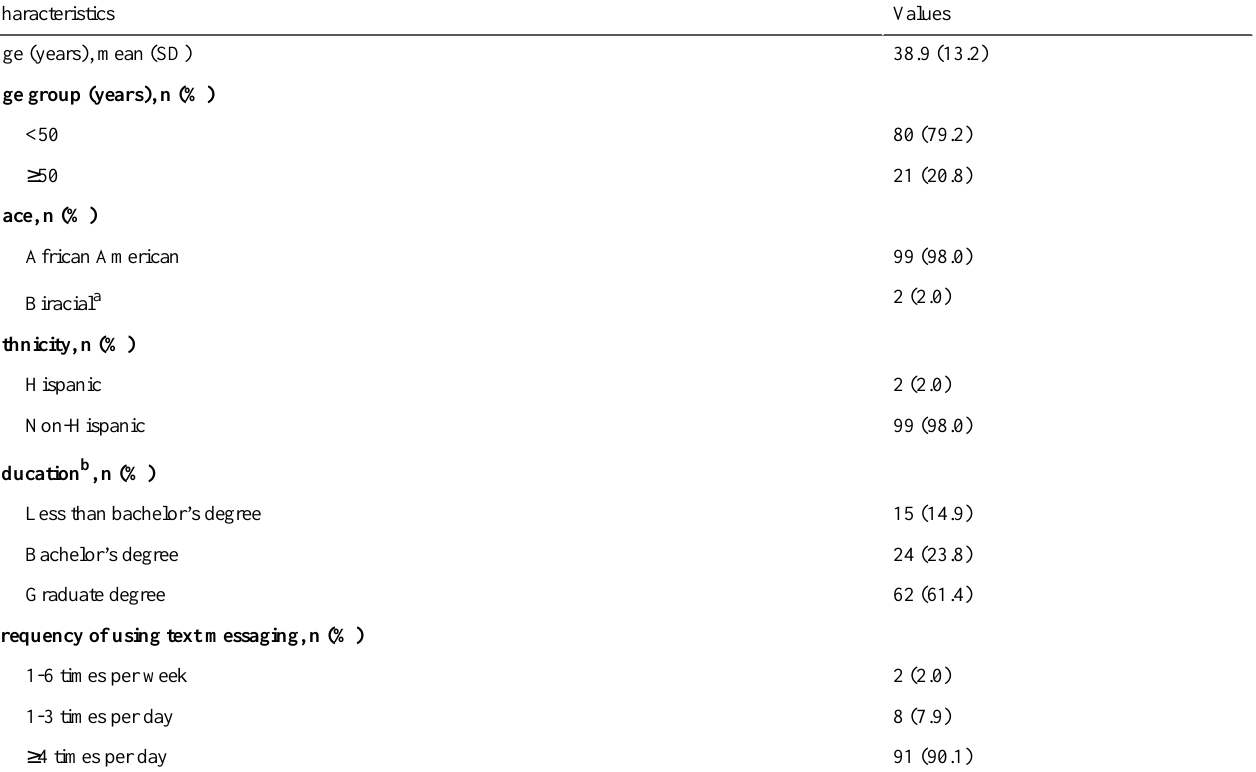
Table 1. Characteristics of study participants (N=101).